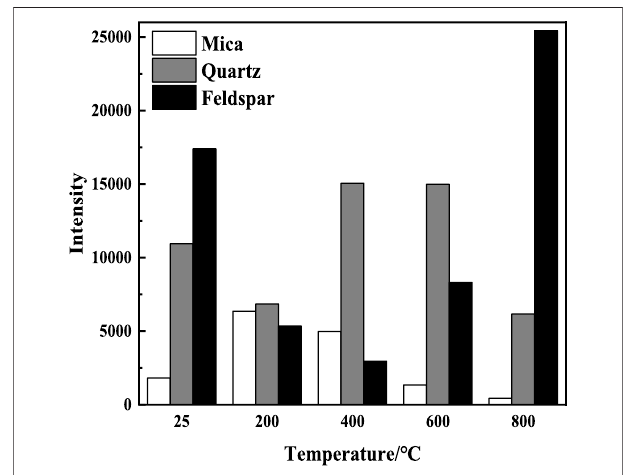
FIGURE 13 | Diffraction intensity of main mineral components of granite at different temperatures.